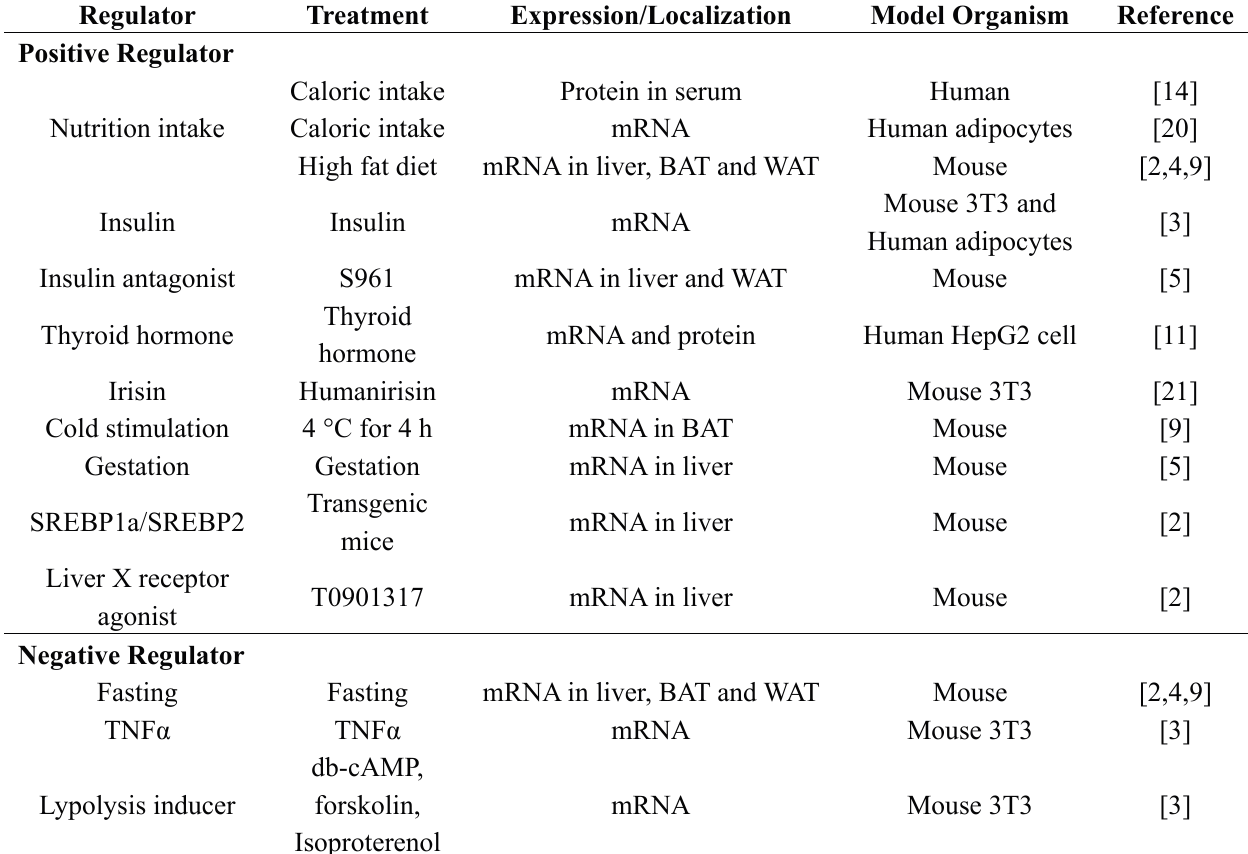
Table 2. Regulation of betatrophin